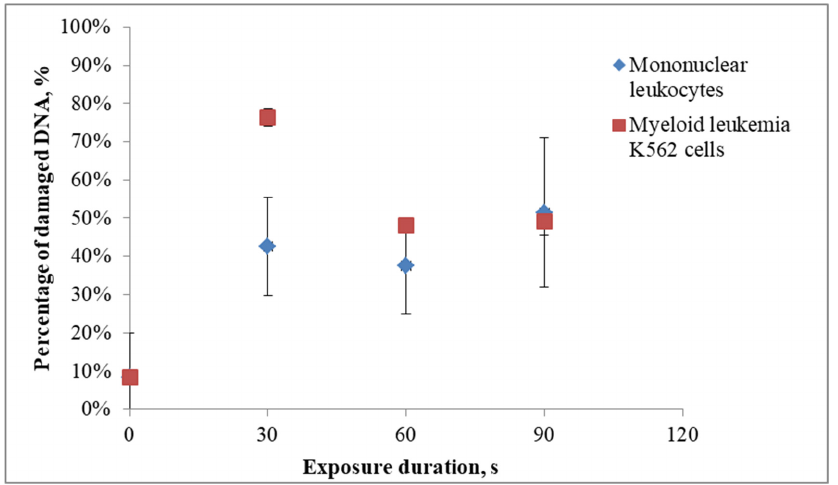
Figure 8. Dependence of the level of damage to the DNA cells on the time of processing by the direct piezodischarge of the physiological solution added to the nutritional medium. The cells were kept in the RPMI nutritional medium with the addition of 10% fetal bovine serum, amphotericin, and gentamycin, in a thermostat with increased CO 2 concentration (5%) at temperature of 37 °C. In detail, the experimental conditions are described in the Section